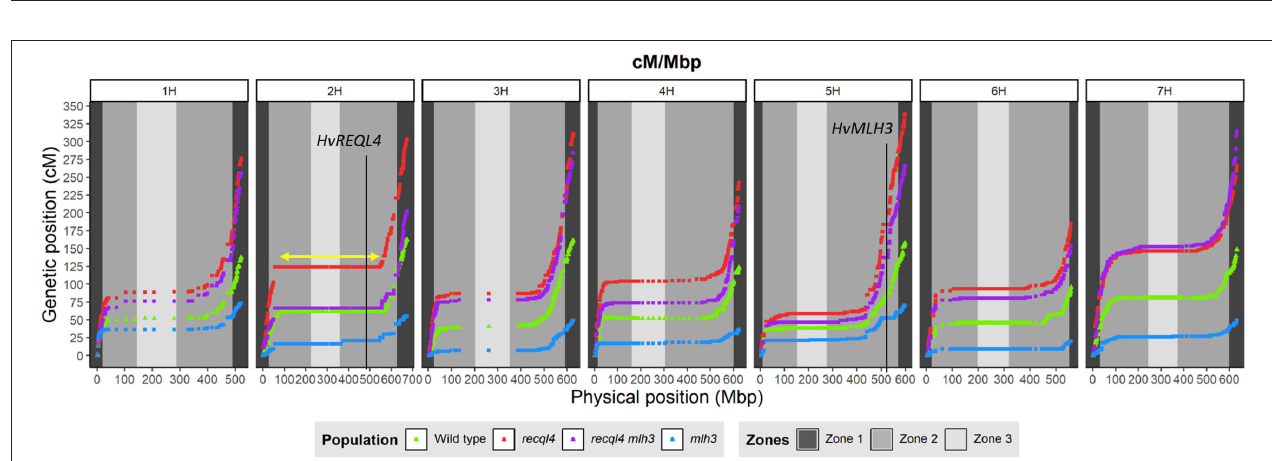
FIGURE 3 | Cytology of male meiosis on F 4 plants of the different populations: (A) WT, (B) mlh3, (C) recql4 , and (D) recql4 mlh3 . White arrows indicate the bivalents counted with three crossovers and asterisks refer to the bivalents with four crossovers. (E) Total chiasmata count per cell and population. The statistical comparison with the WT was carried out with the t -test where “ns” is not significant, *** p < 0.001, **** p < 0.0001. The red triangle shows the mean per genotype. Bar size: 10 µ m.